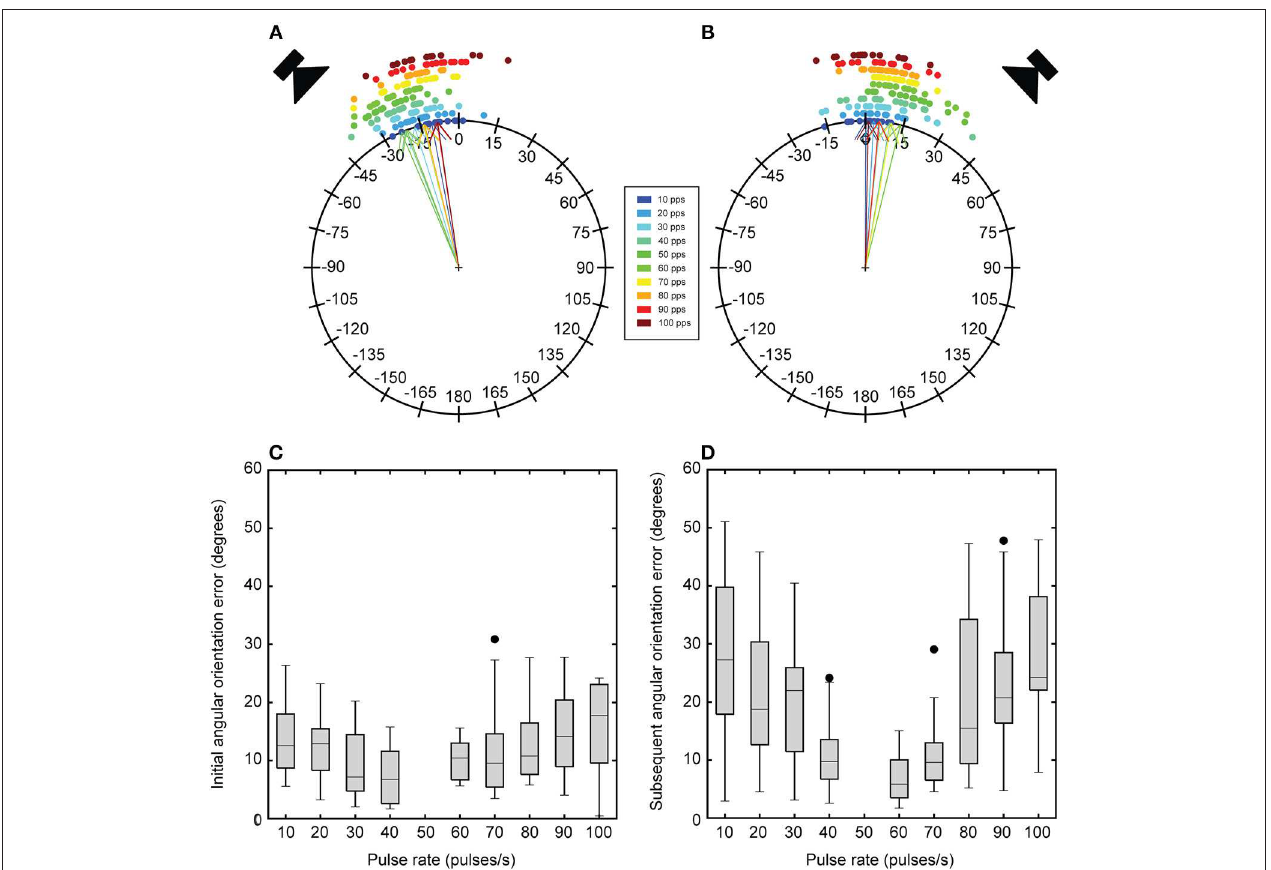
FIGURE 5 | Effects of song pulse rate on mean angular heading and angular orientation error. Circular plots depict the angular headings in response to the initial broadcast location 250ms into stimulus presentation (A) and to the subsequent broadcast location 750ms into stimulus presentation (B) . Dots around the circular plots are mean angular responses in degrees from a single fly to a particular pulse rate (colors). Arrows indicate the grand mean across 16 flies for a particular pulse rate. Initial angular headings vary as a function of song pulse rate. These initial angular headings are generally larger (more negative) and approach the initial broadcast location. Angular headings in response to the subsequent broadcast location are generally more forward directed except for responses to the most preferred pulse rates. These responses exhibit positive angular headings toward the subsequent broadcast location. Box plots depict the first and third quartiles and median angular orientation error in response to the initial (C) and subsequent (D) broadcast locations. Flies exhibit greater orientation error for songs with less preferred pulse rates and these errors are elevated in response to the subsequent broadcast location. Whiskers show the most data extreme points that are not considered outliers, and closed circles indicate